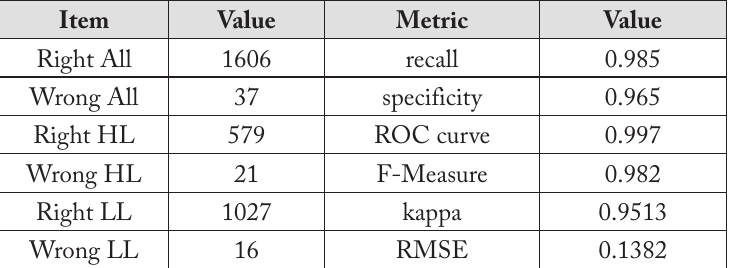
AJIC Issue 30, 2022 23